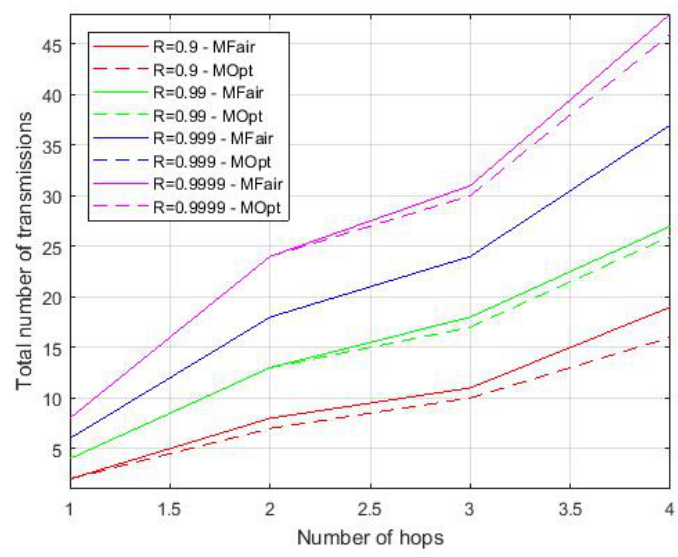
Figure 4. Total number of transmissions for a flow